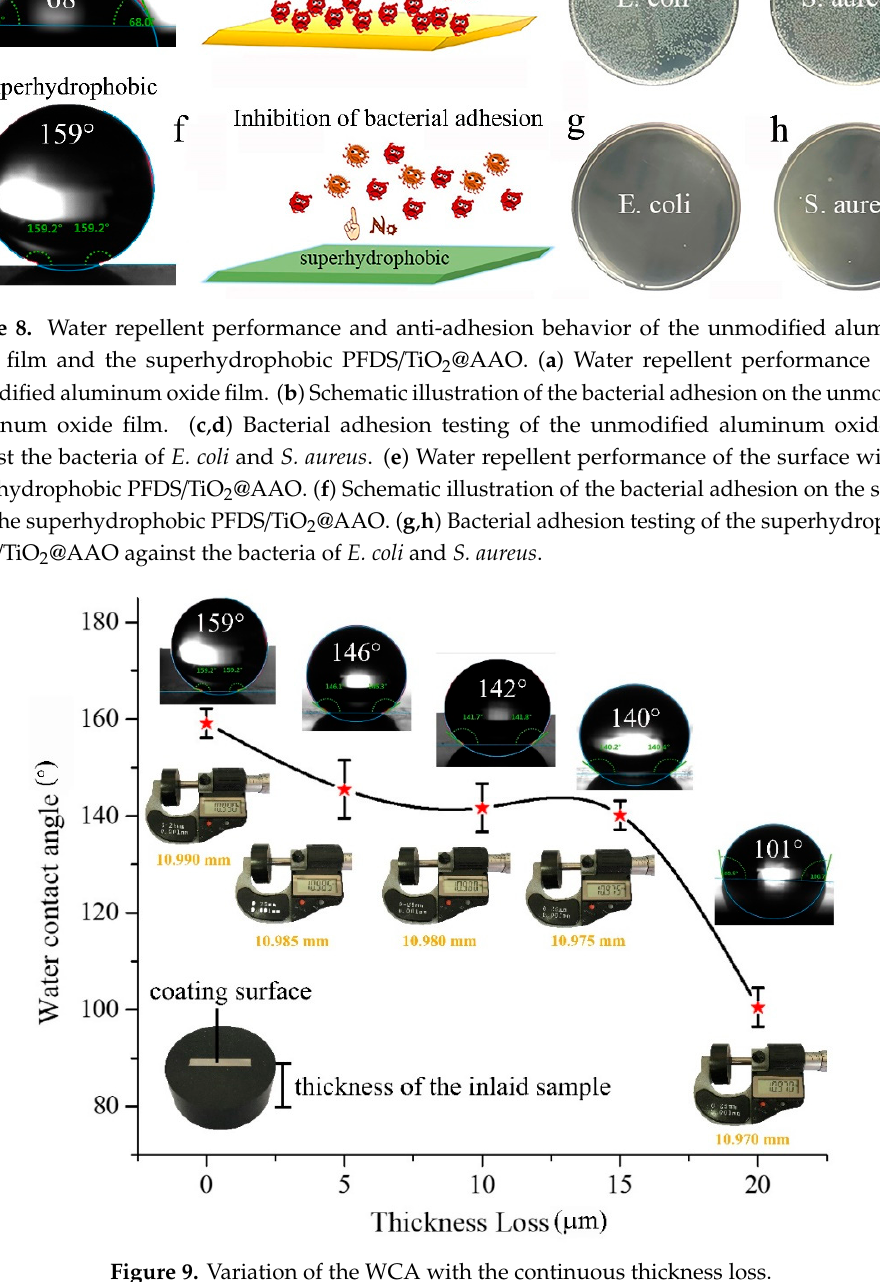
Figure 9. Variation of the WCA with the continuous thickness loss.